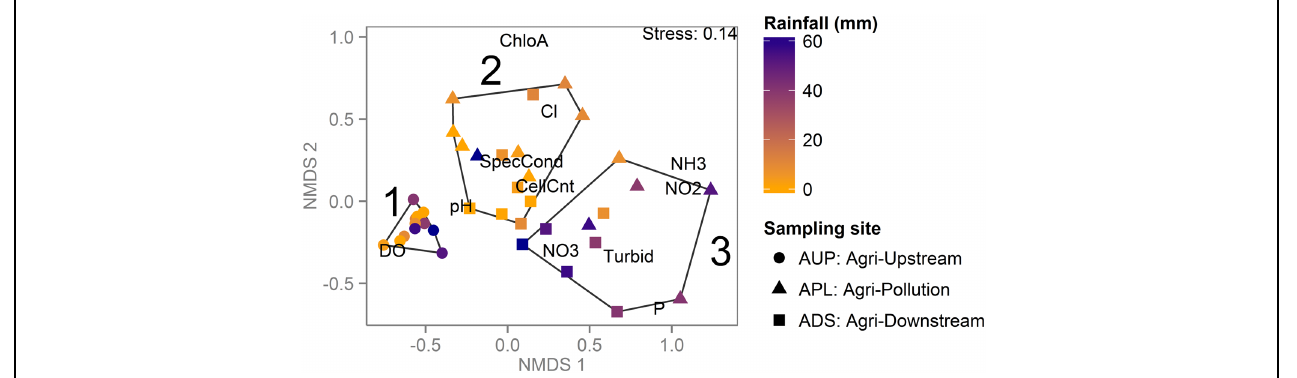
FIGURE 5 | Agricultural watershed samples clustered by water chemistry reveal impact of land use and rainfall. NMDS plot based on environmental and chemical water measurements for samples from the agricultural watershed. Each point represents a sample, colored by cumulative rainfall over 3 days prior to sampling and shaped by sampling site. Significant clusters are outlined and numbered in black. Samples collected upstream of agricultural activity (Cluster 1) have higher DO levels. Samples collected in the summer from the agriculturally affected sites (Cluster 2) have higher chlorophyll a concentration, while the winter samples are more affected by runoff, as indicated by higher nutrient levels and turbidity (Cluster